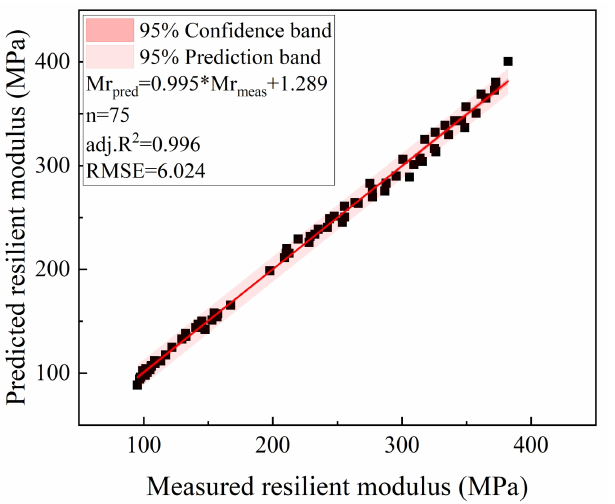
Figure 16. Comparison of the laboratory-measured resilient modulus values against those predicted from the new improved model (Equation